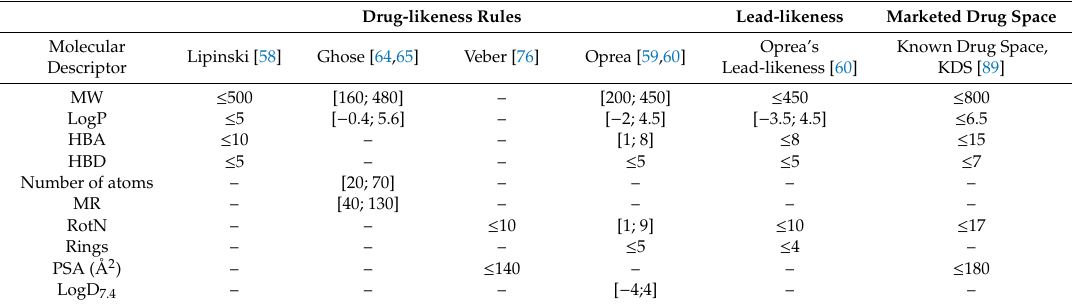
Table 2. Several drug-likeness